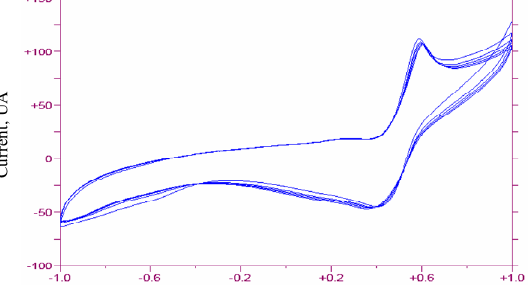
Figure 5. Cyclic voltammogram of potential cycling for the oxidation of paracetamol at the MgB /GCE in 0.1 M KH PO (pH 6.0). potential scanning in the positive direction from - 2 2 4 1000 to +1000 mV vs. Ag/AgCl at a scan rate of 100 mV/s for 10